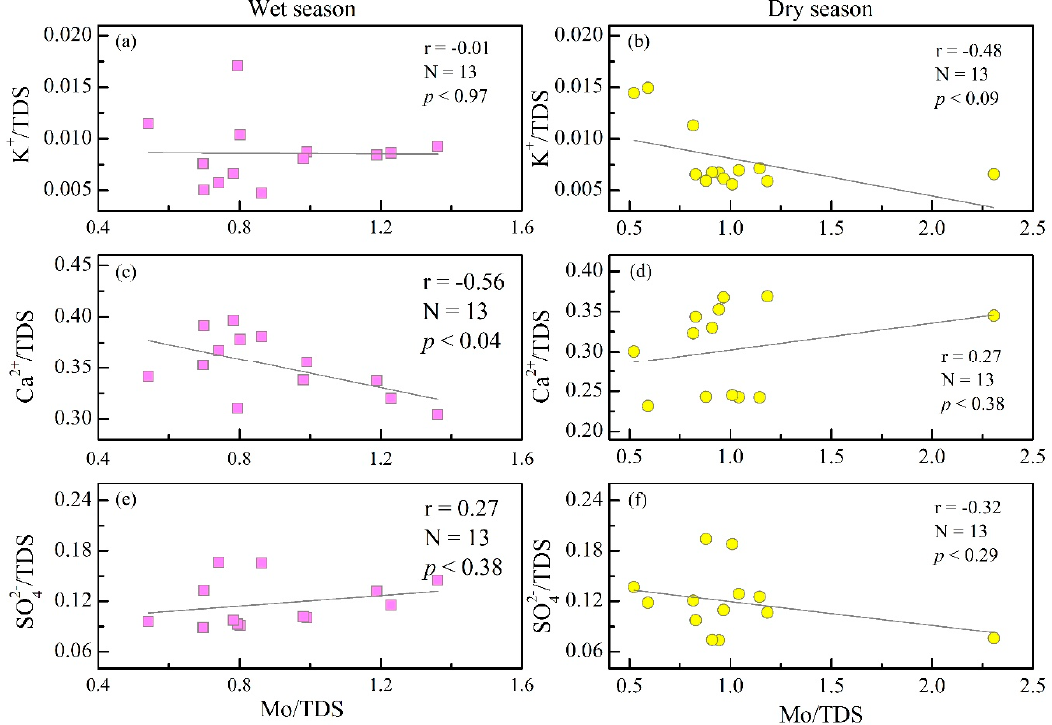
Figure 4. Correlations between Mo/TDS and K + /TDS, Ca 2+ /TDS and SO 42 − /TDS of upper XJR water; Mo/TDS versus K + /TDS in wet season ( a ) and dry season ( b ); Mo/TDS versus Ca 2+ /TDS in wet season ( c ) and dry season ( d ); Mo/TDS versus SO 42 − /TDS in wet season ( e ) and dry season ( f ).